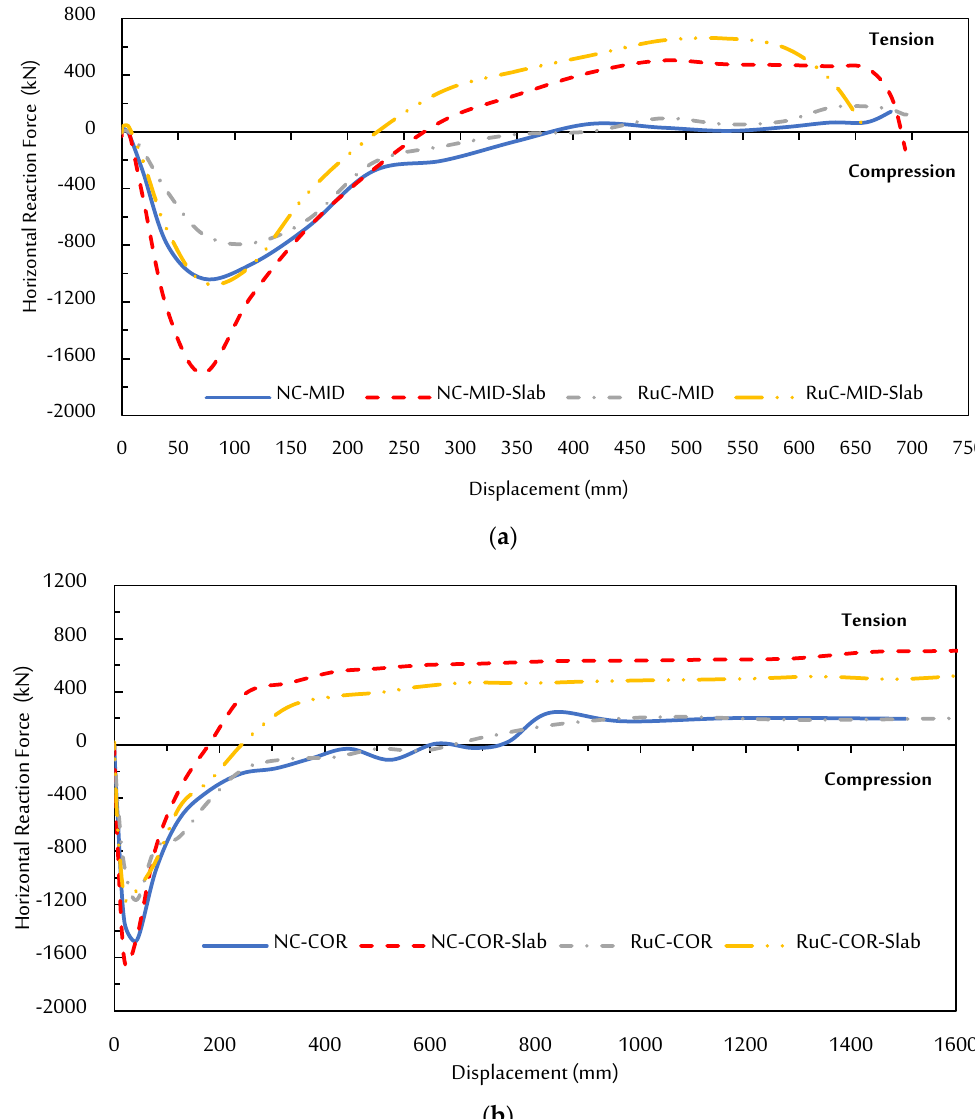
Figure 20. Horizontal reaction force–displacement curves: ( a ) Scenario “A” specimens and ( b ) Sce- nario “B” specimens.